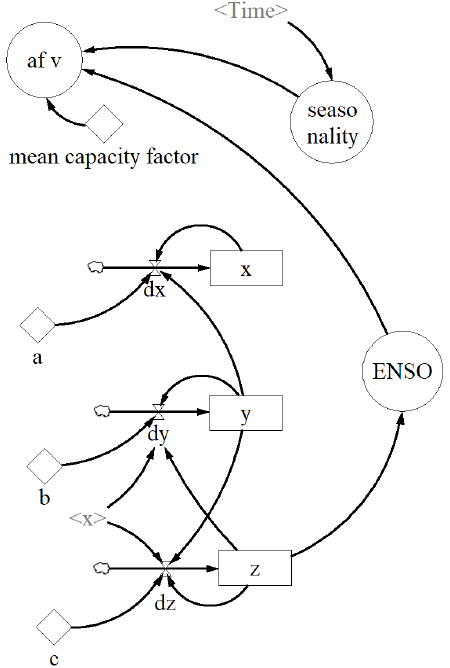
Figure 7. SD modeling of the ENSO phenomenon. Stock-flow structure of af v .